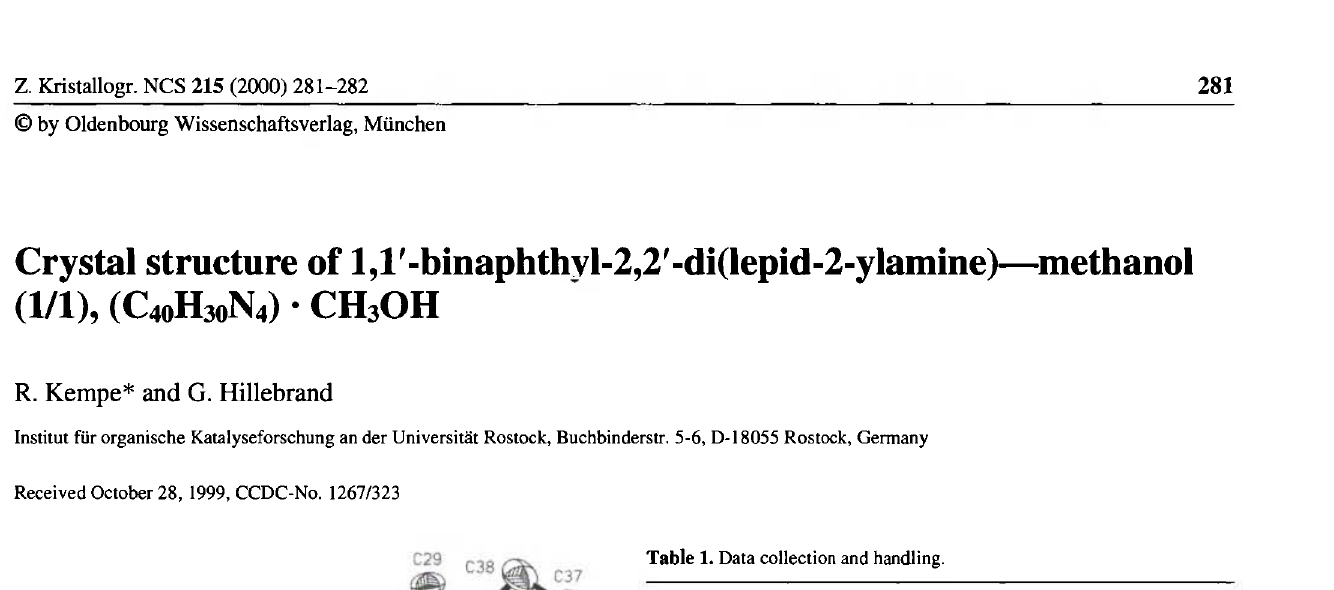
Table 2. Atomic coordinates and displacement parameters (in Ä 2